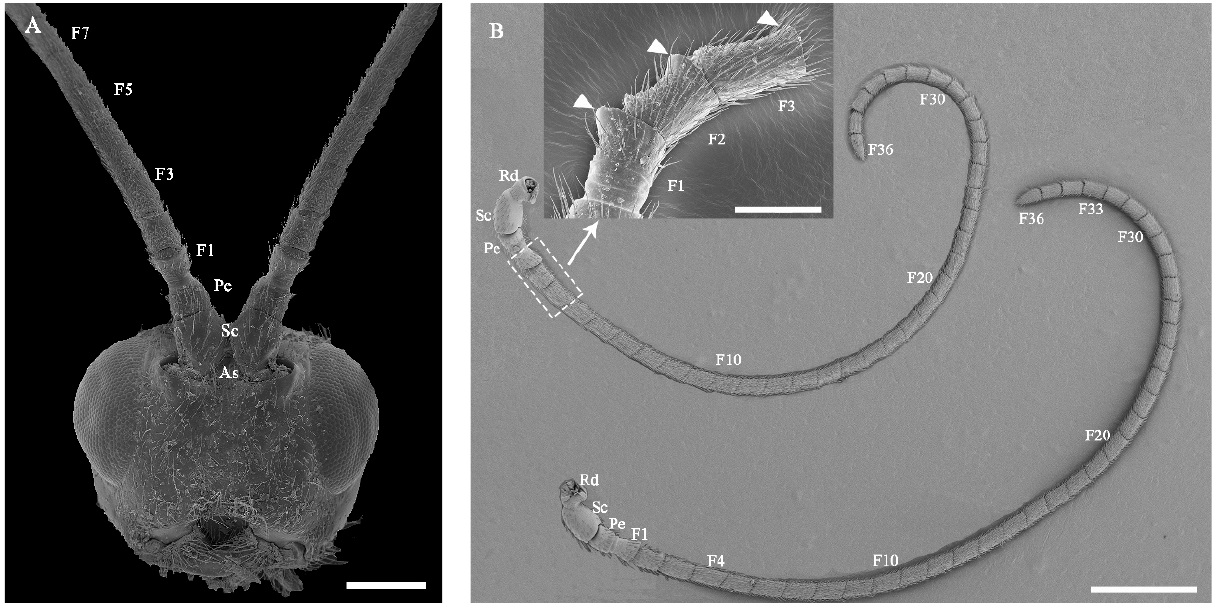
Figure 2. Head and antennae of adult C. qinlingensis . ( A ) The antenna base is situated in a single socket-like area of the head wall. ( B ) Whole antennae of female ( top ) and male ( bottom ) wasps. The inset shows strong protuberances when viewed apicoventrally (triangular arrow). As, antennal socket; Rd, radicula; Pe, pedicel; Fl, flagellum; F1–F36, flagellomere number. The same acronyms and abbreviations are used in subsequent figures. Scale bar: A = 200 µ m; B = 500 µ m, Inset = 100 µ